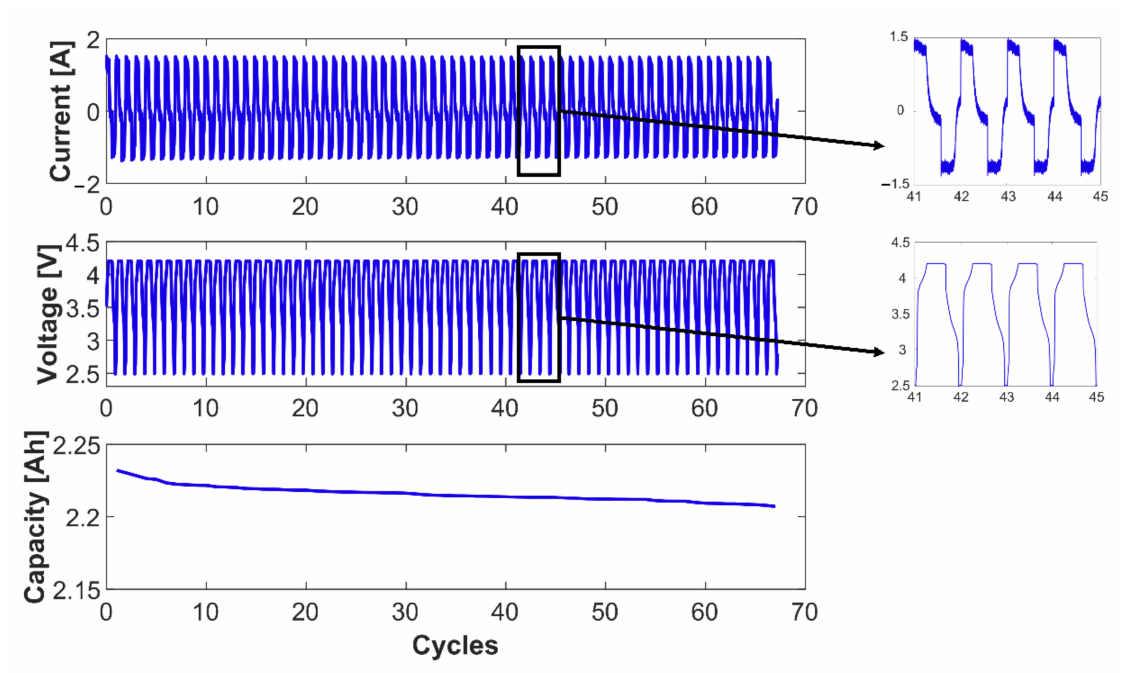
Figure 8. Experimental results of an individual cell in the battery pack over a variable current charge profile: current profile, measured cell voltage, capacity.